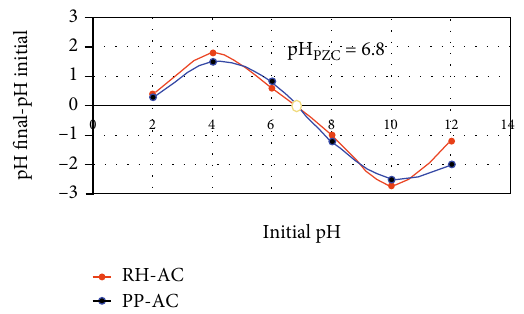
Figure 5: The point of zero charge plot for RH-AC and